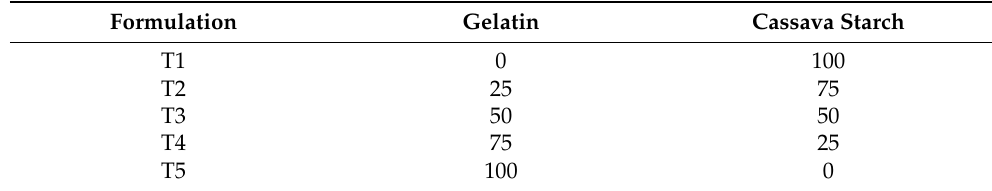
Table 1. Different cassava starch/gelatin weight ratios for the preparation of composite membranes. Formulation